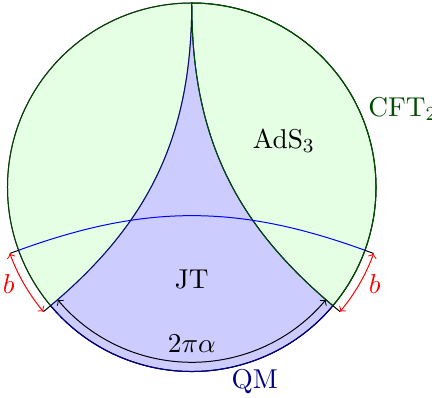
Figure 1. AdS 3 -Poincaré, partially reduced over the angle 2 πα . The purple region is the 2D JT extremal black hole, and the green region is dual to the bath 2D CFT. The blue geodesic computes the entropy of the region [0 , b ] in the CFT, including the quantum mechanical